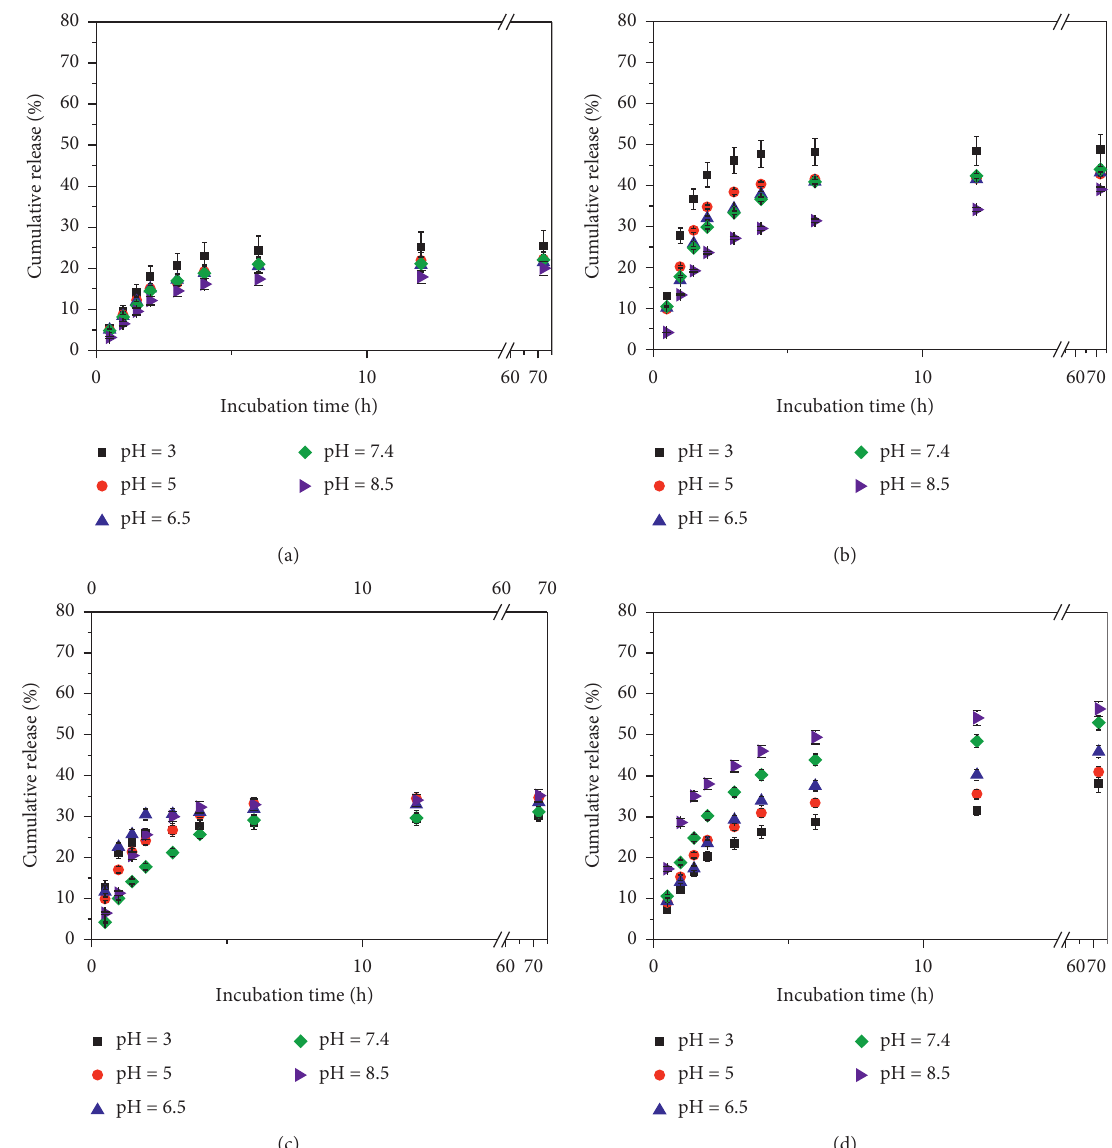
Figure 5: Drug release profiles of Doxy in nanocarriers at different pH and loading time: (a) TMPAC-MSNs, (b) TMPAC-MSNs-NH (c) TMPAC-MSNs-SH, and (d) TMPAC-MSNs-SO −